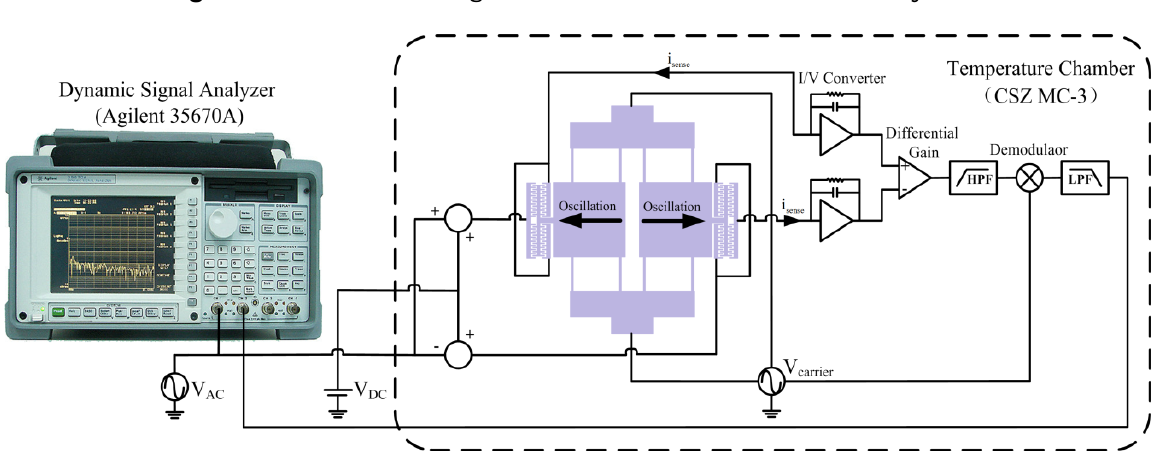
Figure 10. Schematic diagram of the electrical measurement